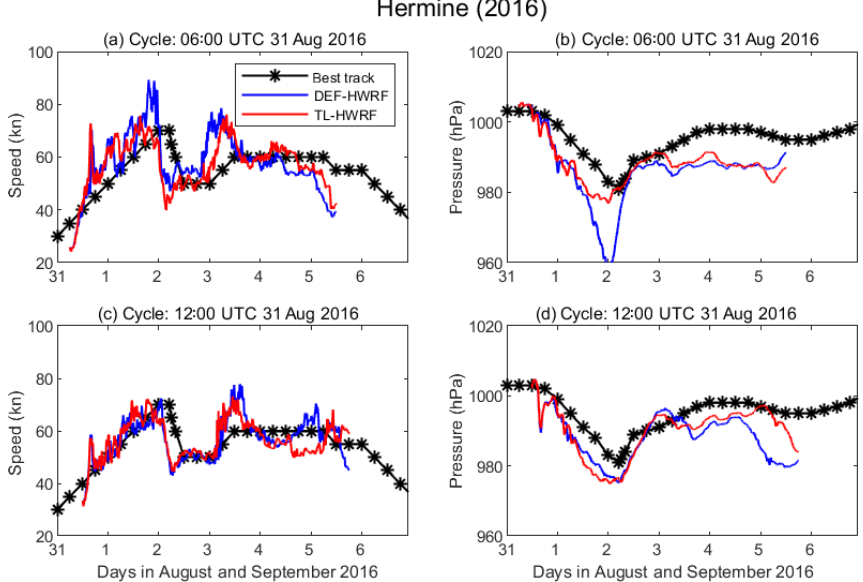
Figure 15. Comparison of HWRF-simulated maximum surface wind speed, storm central pressure, and track of Hermine (2016) with the best-track data (black). Blue curves: DEF-HWRF. Red curves: TL-HWRF.